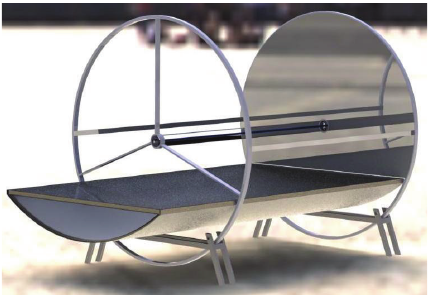
Figure 4: Final design of the cylindrical collector showing southern cylindrical and northern flat secondary mirrors for latitudes > 23 ∘ 26 󸀠 14 󸀠󸀠